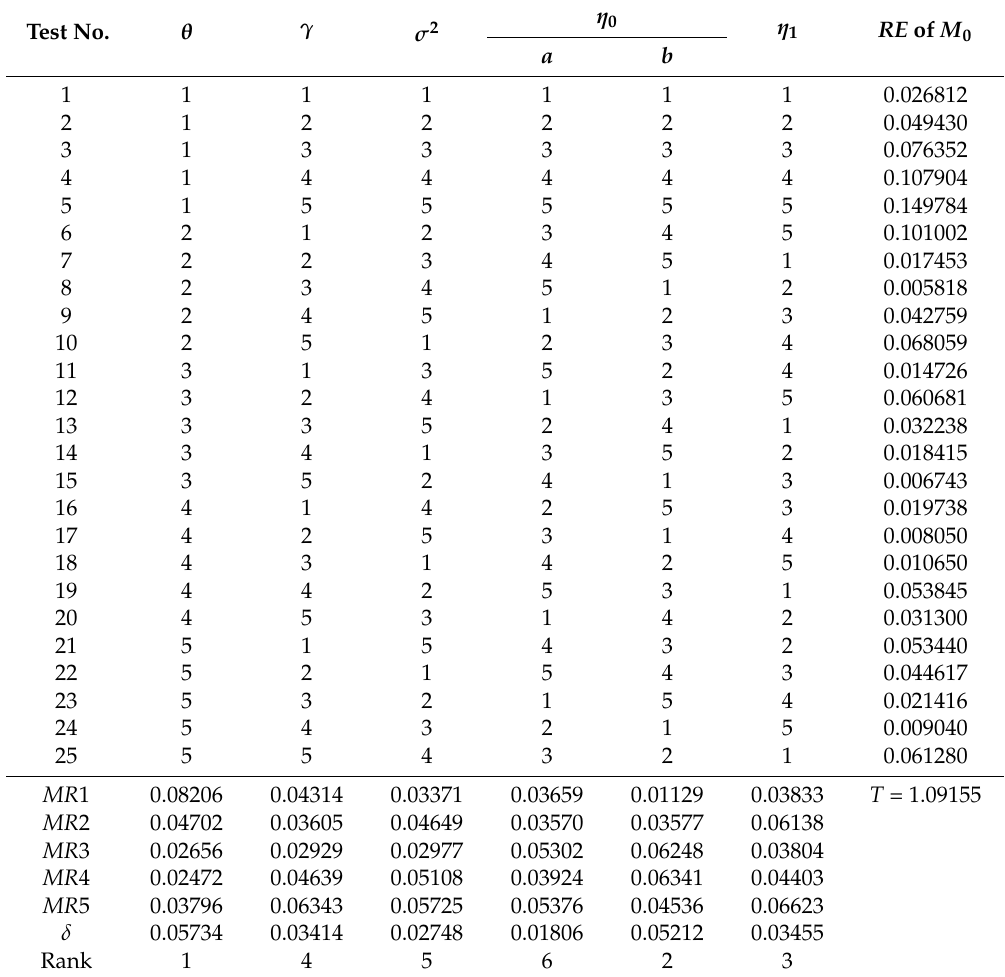
Table 2. Sensitivity analysis of M 0 with five levels of parameters through the orthogonal array L 25 (5 6 ) and Taguchi